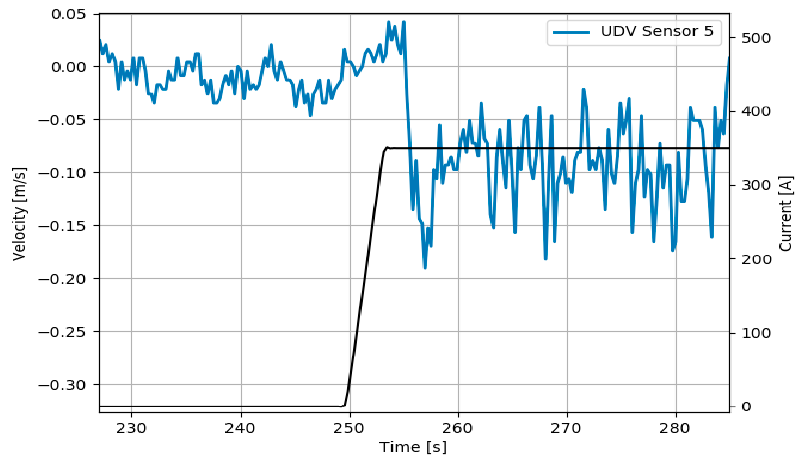
Figure 5. Dynamic velocity response to step increase in current from 0 A to 350 A [16].